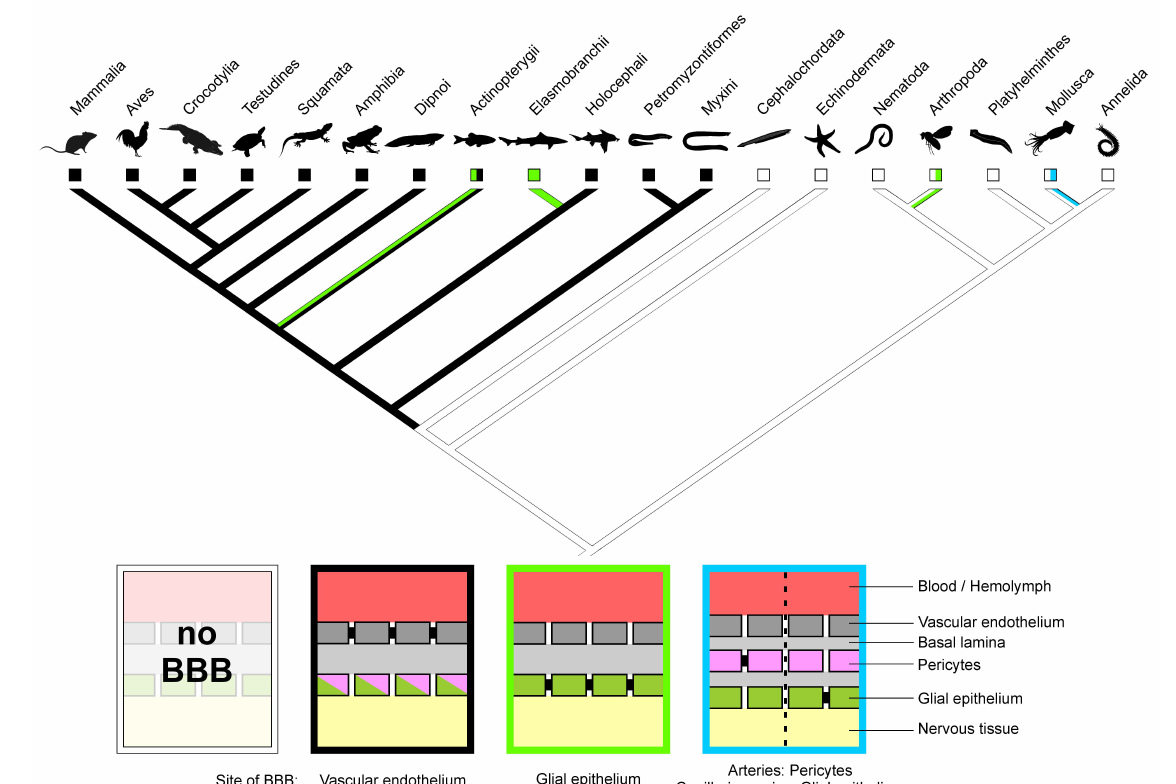
Figure 1. Evolution of blood-brain barriers in Bilateria. Parsimony-based reconstruction of ancestral states shows BBB at the vascular endothelium as apomorphy of vertebrates; glial BBBs have evolved multiple times independently. Boxes show simplified depictions of the BBB; localization of the BBB is indicated by black occlusions between cells. Box color refers to character state in the cladogram. Phylogeny simplified after [27–30]; most invertebrate taxa without a BBB have been left out for sake of simplification. Ancestral state reconstruction was performed using Mesquite 3.61 [31] silhouette images courtesy of